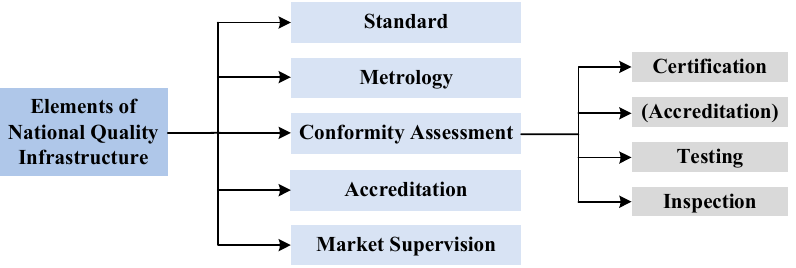
Figure 1. Elements of National Quality Infrastructure.